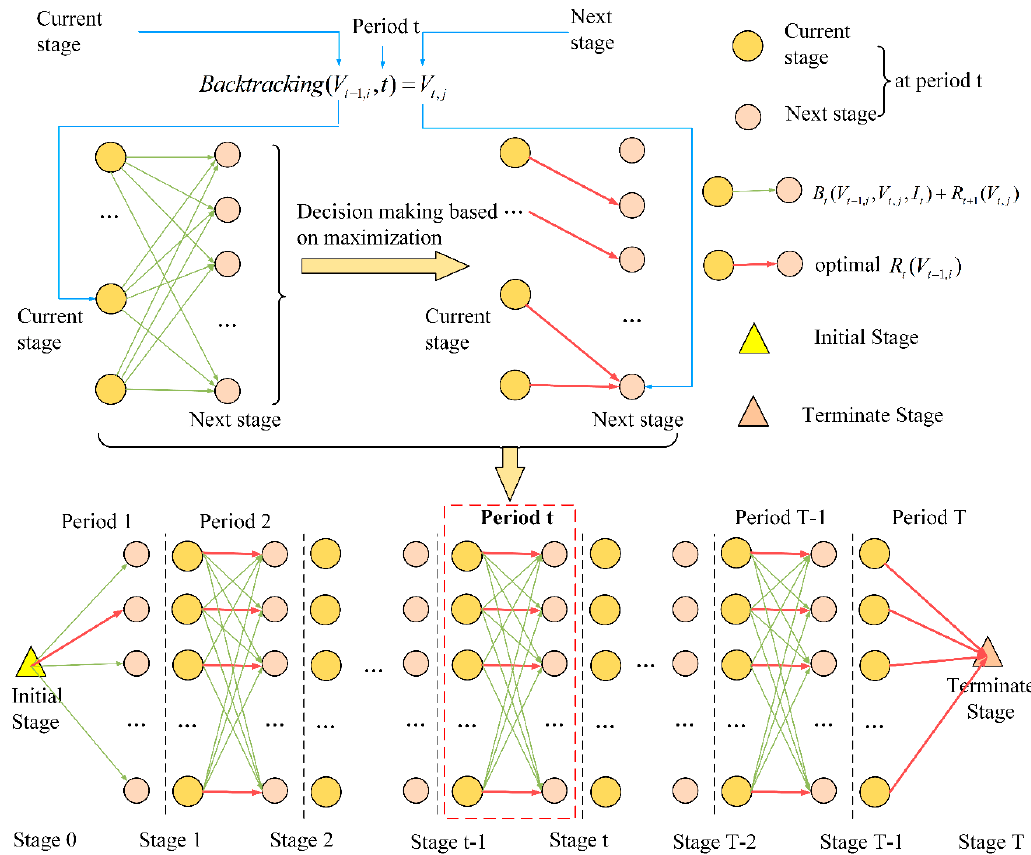
Figure 1. The decision-making process of dynamic programming (DP) for reservoir operation.